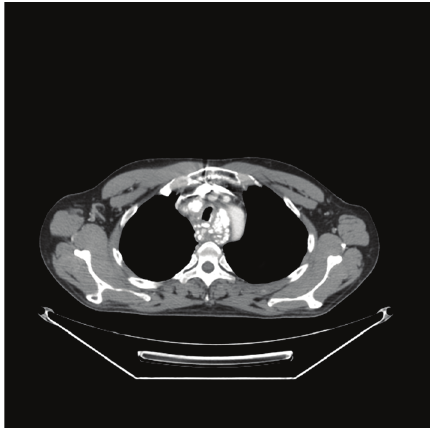
Figure 3: Lobulated, calcified esophageal mass at T4 level, as seen on CT scan. The mass almost completely surrounds the trachea and essentially obliterates the esophagus. Extensive calcification of a soft tissue mass and its presumed metastases should make one consider EOO as a possible